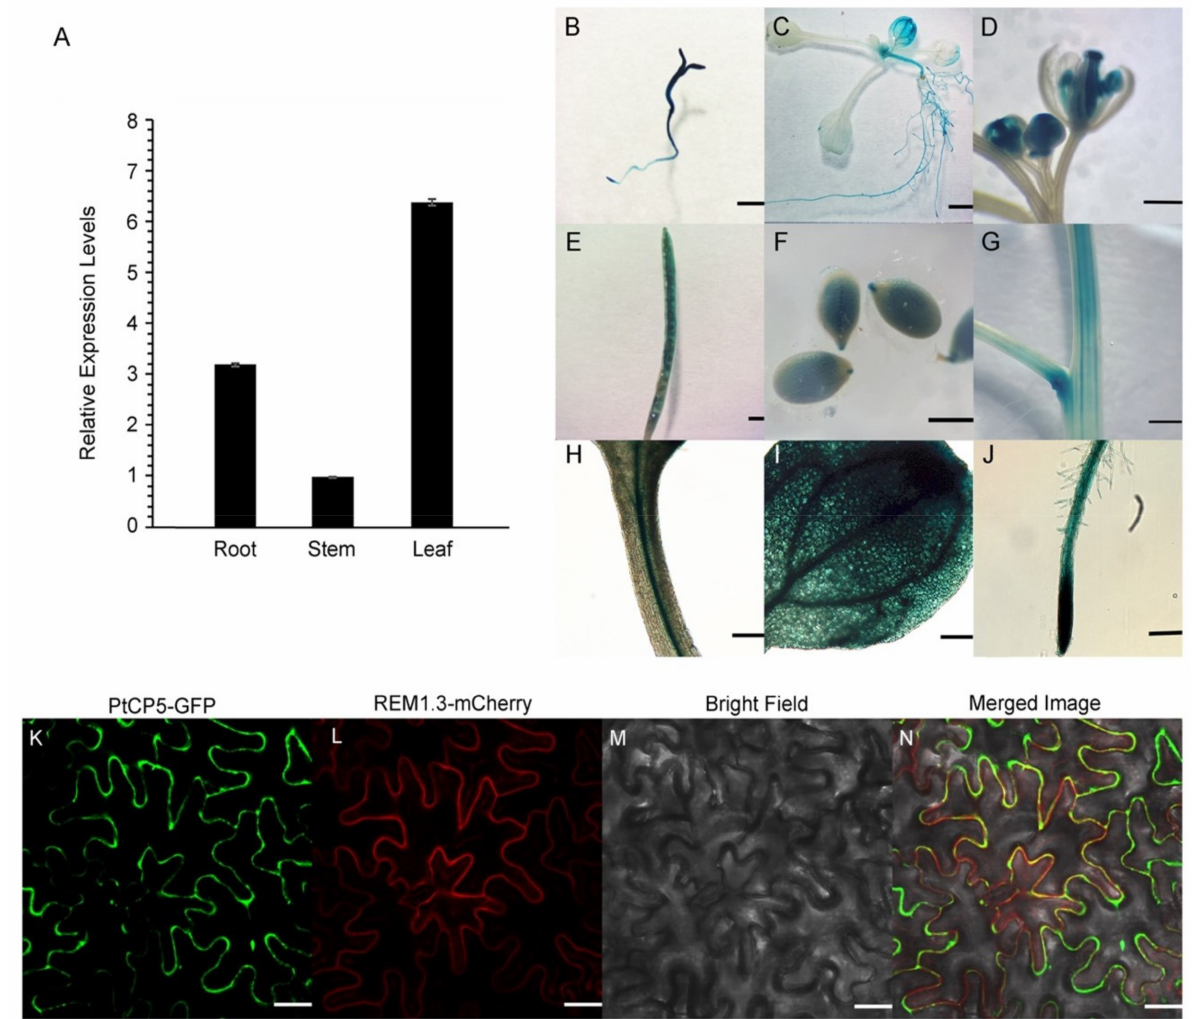
Figure 3. Expression patterns of PtCP5: ( A ) PtCP5 in P. trichocarpa . The expression levels were normalized to that of β -actin-F and β -actin-R. Data are mean ± SE ( n = 3 experiments). ( B – J ) pro PtCP5:GUS expression patterns in Arabidopsis : seedling ( B ); cotyledons ( C ); flower ( D ); siliques ( E ); seed ( F ); stem ( G ); petiole ( H ); leaf ( I ); and root ( J ). ( B – G ) bar = 1 mm, ( H – J ) bar = 250 µ m. ( K–N ) Subcellular fluorescence localization of PtCP5-GFP, bar = 30 µ